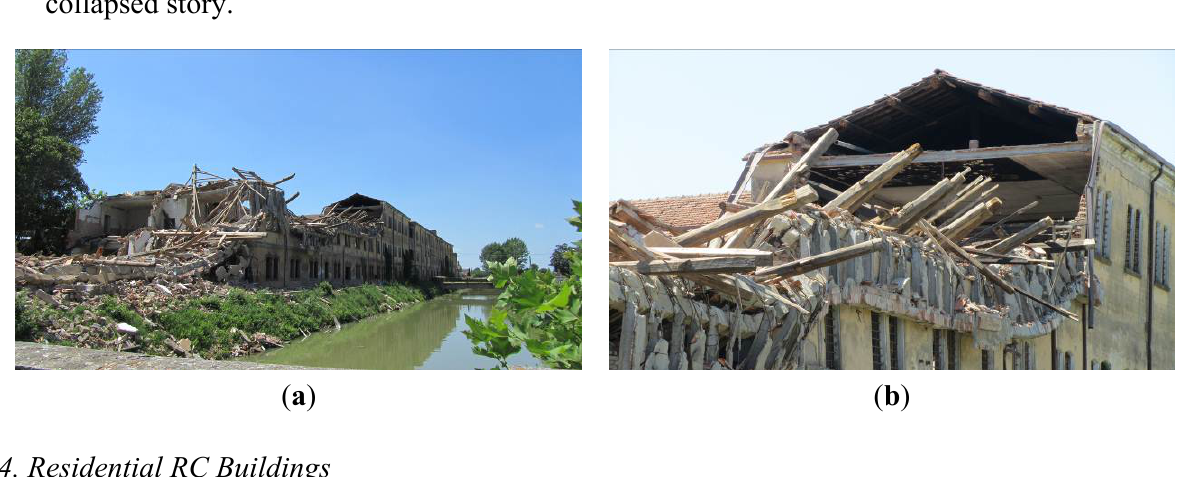
Figure 10. Industrial masonry building partially collapsed: ( a ) Global view; ( b ) Detail of collapsed